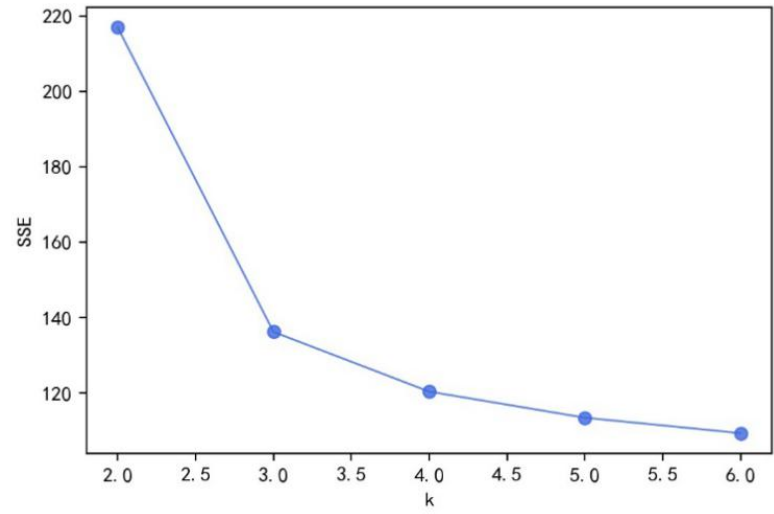
Figure 3. The SSE when k lies in [2, 6].